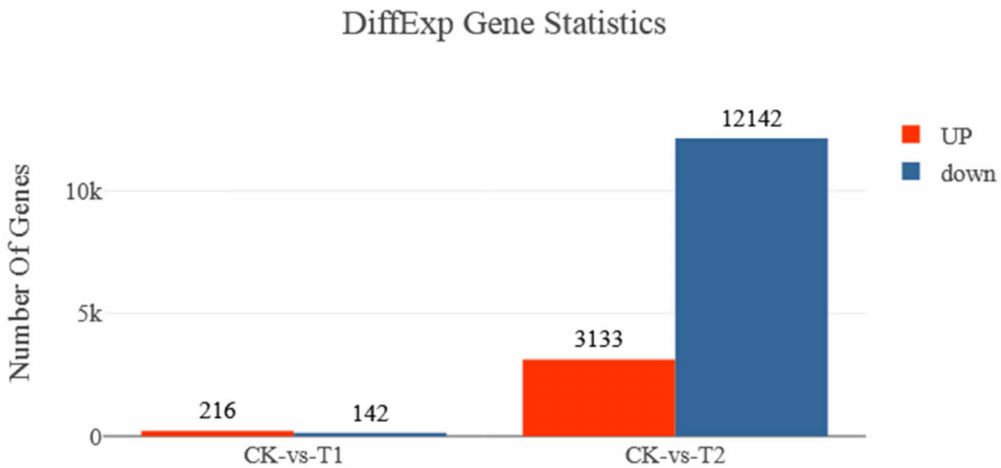
Figure 3. The number of di ff erentially expressed genes (DEGs) at two groups compared with that at CK group. CK represents Control group, T1 represents 0.1 mg.L − 1 BPA treatment group, and T2 shows 10 mg.L − 1 BPA treatment